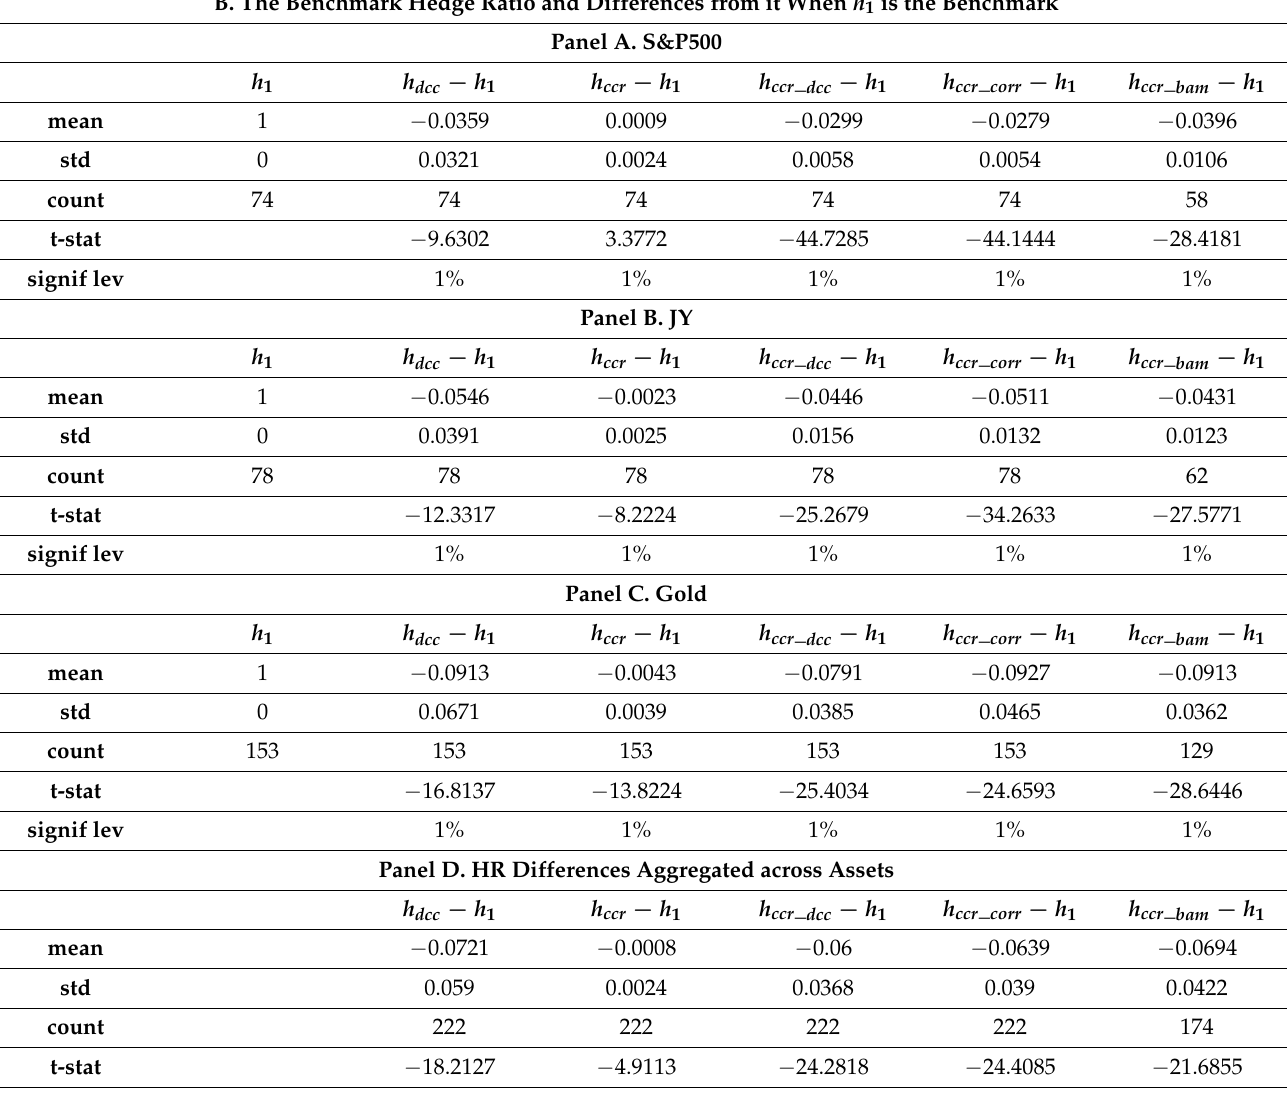
B. The Benchmark Hedge Ratio and Differences from it When h 1 is the